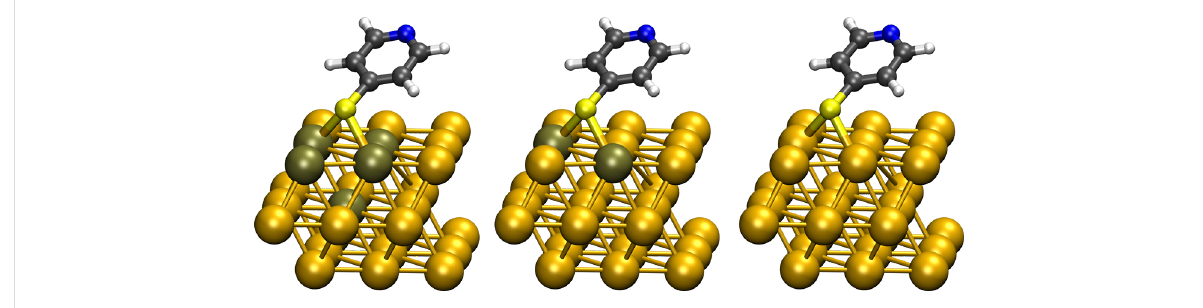
Figure 7: Active atoms for the partial Hessian: 4-Mercaptopyridine adsorbate plus different number of Au atoms, indicated by a darker color; left : mpy-ads-5, middle : mpy-ads-2, right : mpy-ads-0.